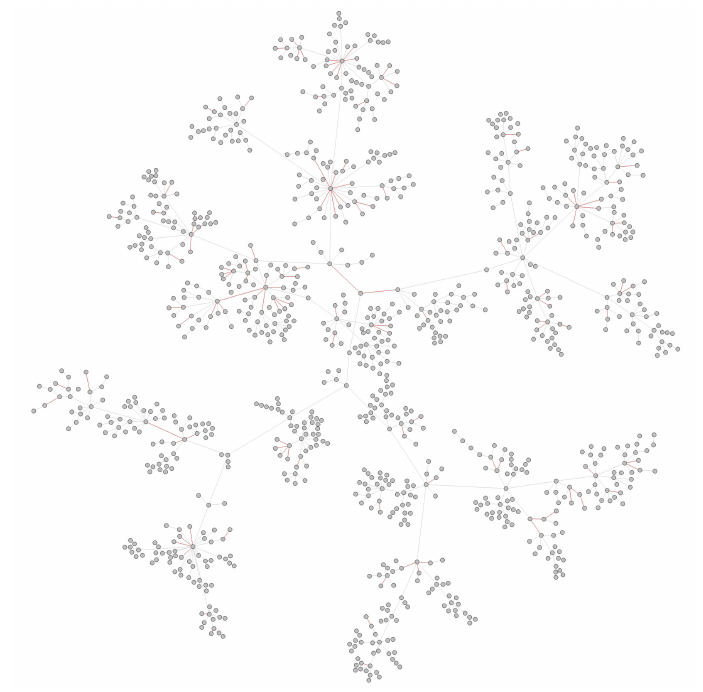
Figure 8. Abnormal edges in Australia transmission network.